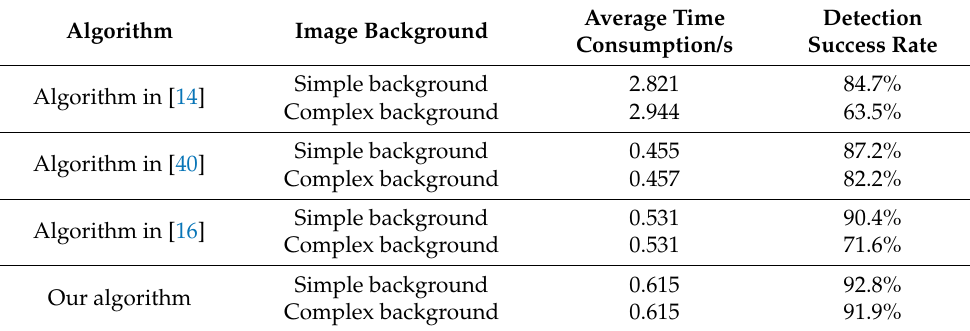
Table 3. Comparison of time consumption and detection rate with other algorithms.